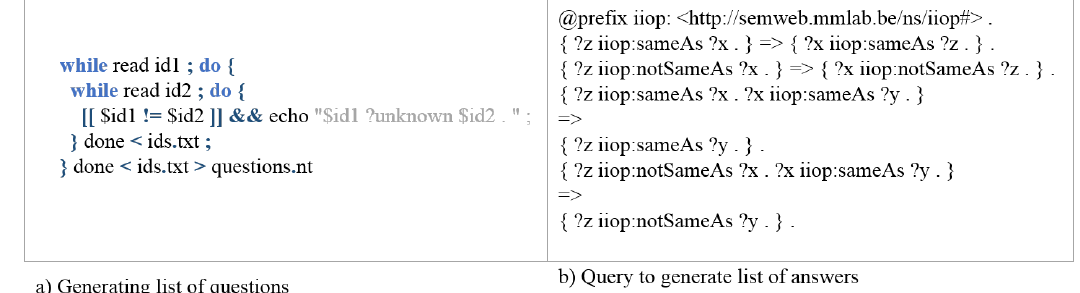
Figure 5. Computing identifier interoperability